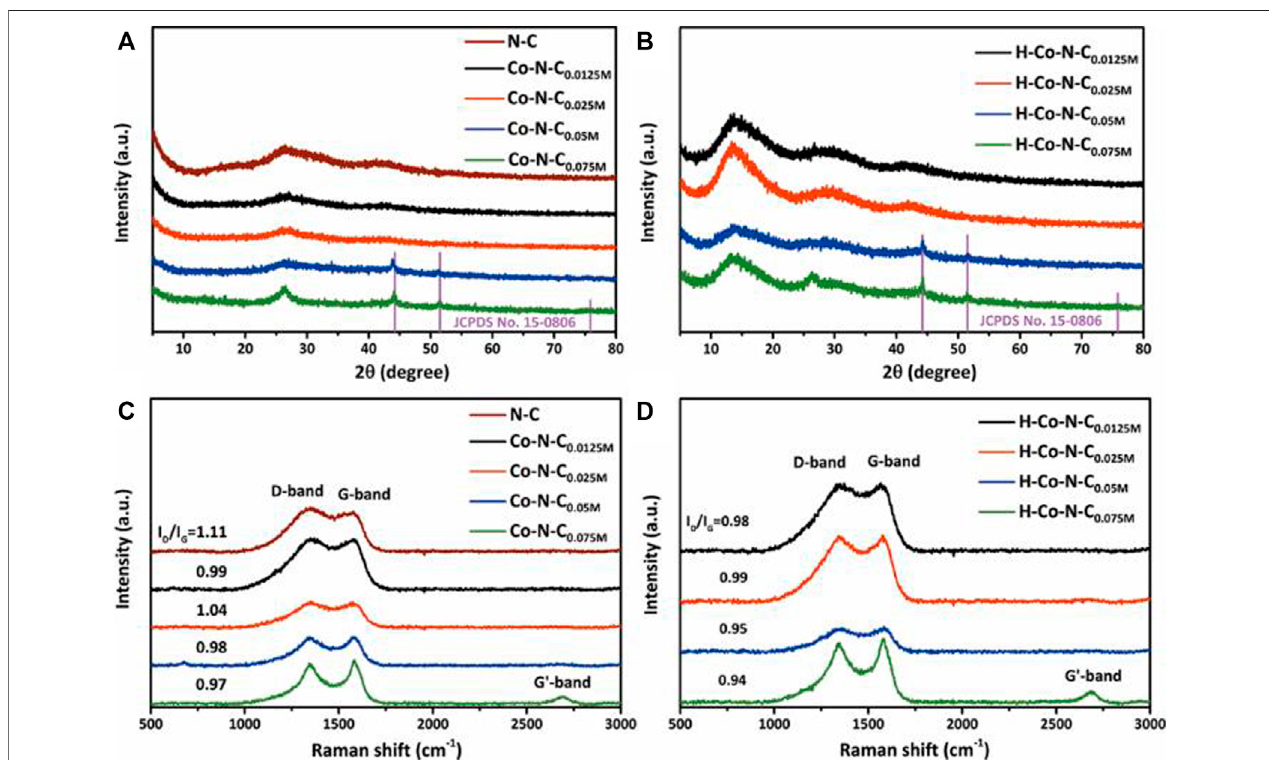
FIGURE 2 | XRD patterns of (A) N-C, Co-N-C X and (B) H-Co-N-C X , and Raman spectrum of (C) N-C, Co-N-C X , and (D) H-Co-N-C X .